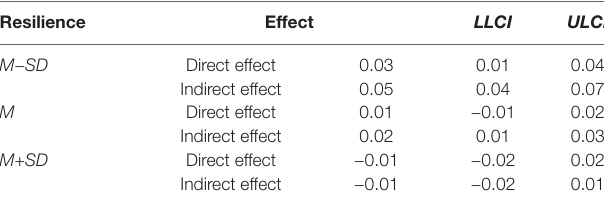
TABLE 4 | The direct and indirect effects at different levels of